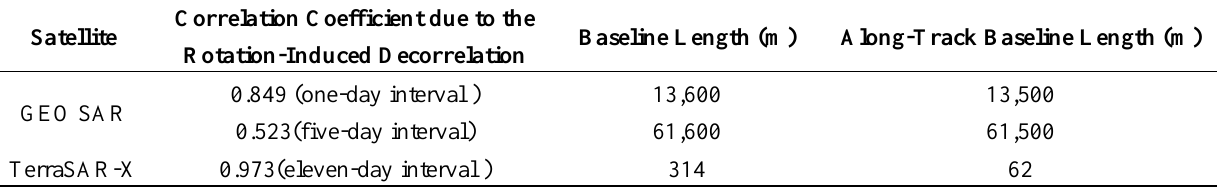
Table 3. Correlation coefficient due to the rotation-induced decorrelation and the baseline analysis of GEO SAR (perigee) and TerraSAR-X (Track 57, Frame 9242, and Track 57, Frame 9409) under the zero-Doppler centroid (ZDC) data